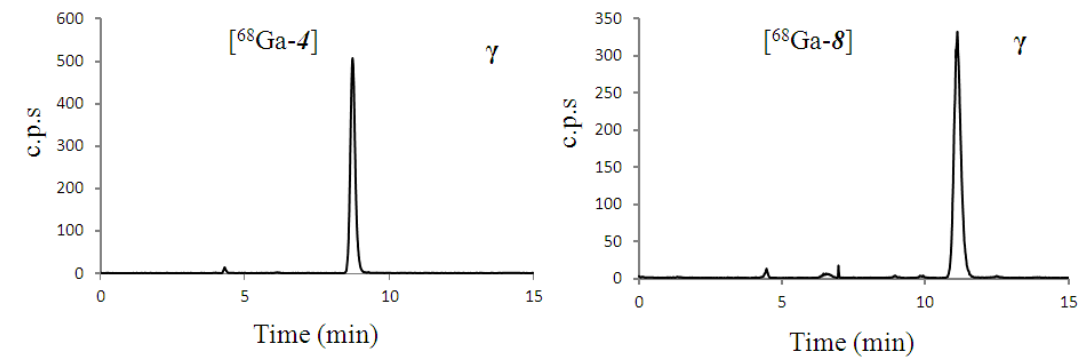
Figure 2. Analytical radio-trace chromatograms of complexes [ 68 Ga- 4 ] and [ 68 Ga- 8 ] produced in high yield from ~28 MBq of [ 68 Ga(OH